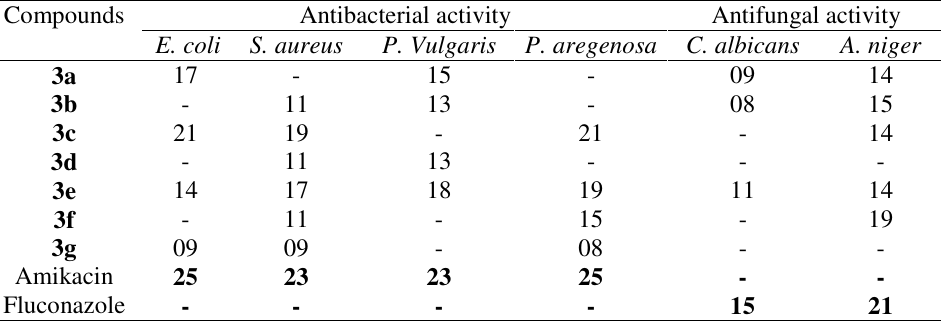
Table 2. Antimicrobial activities of compounds